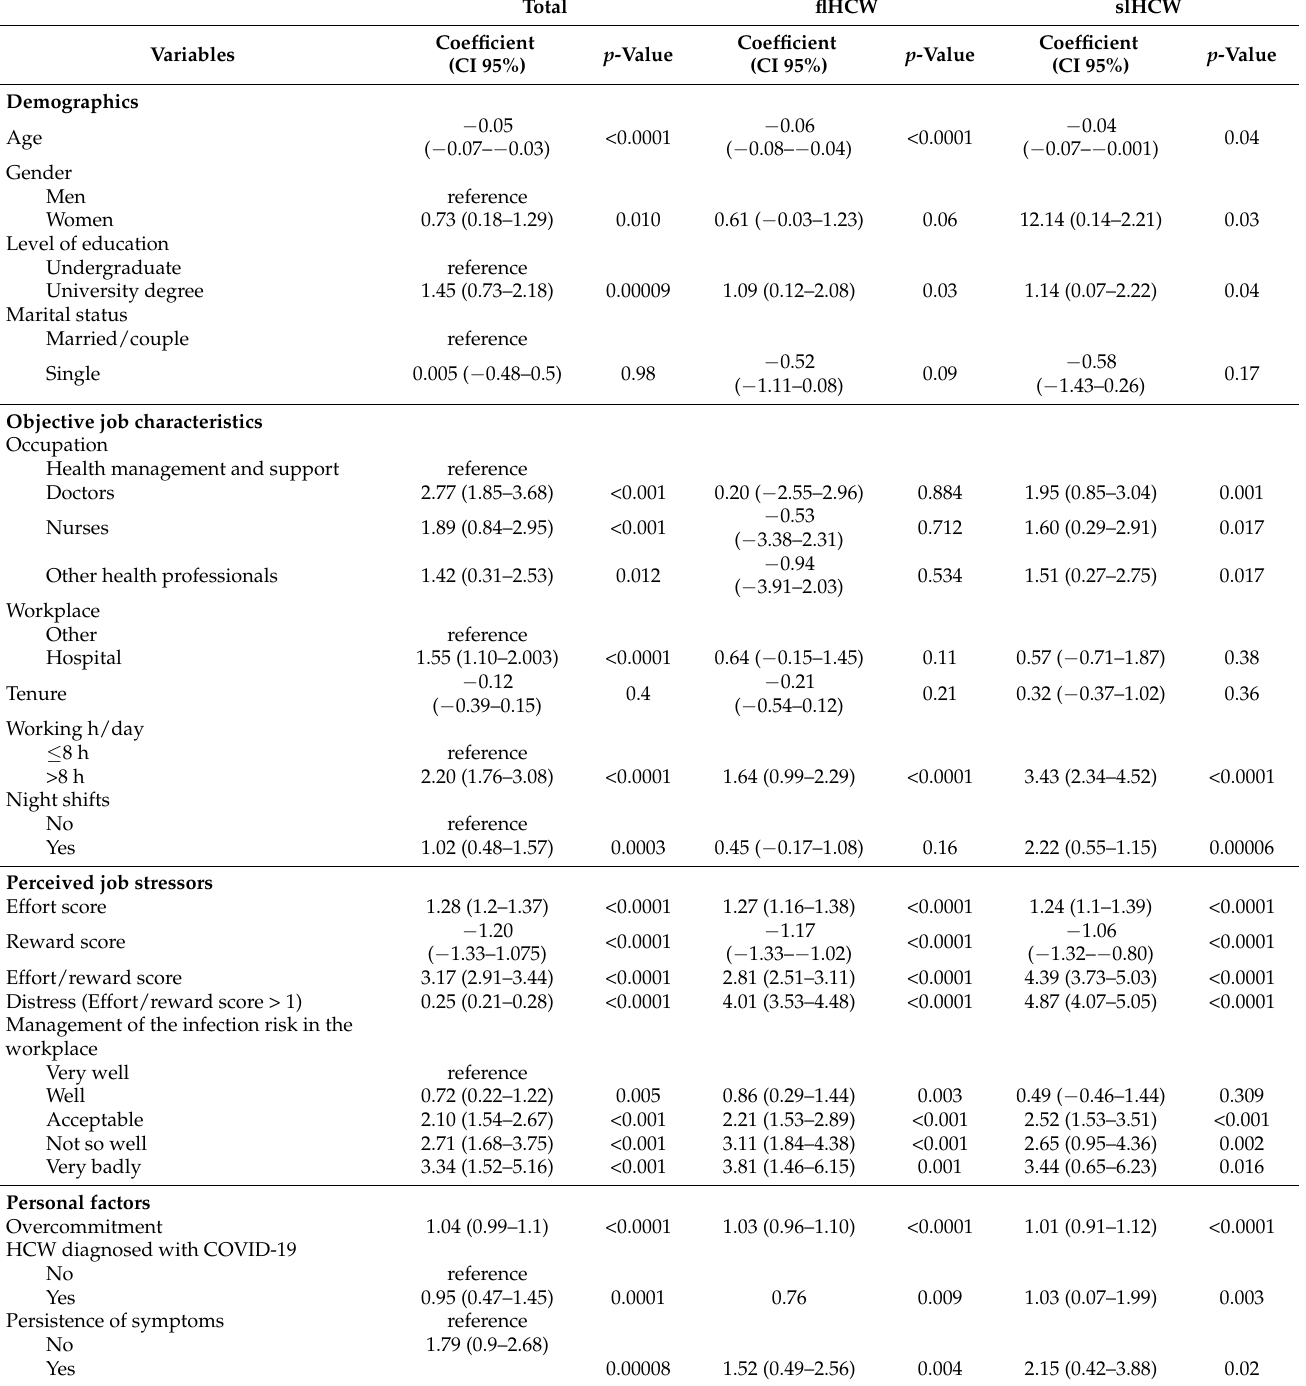
Table 2. Univariate relation between the determinants and high exhaustion